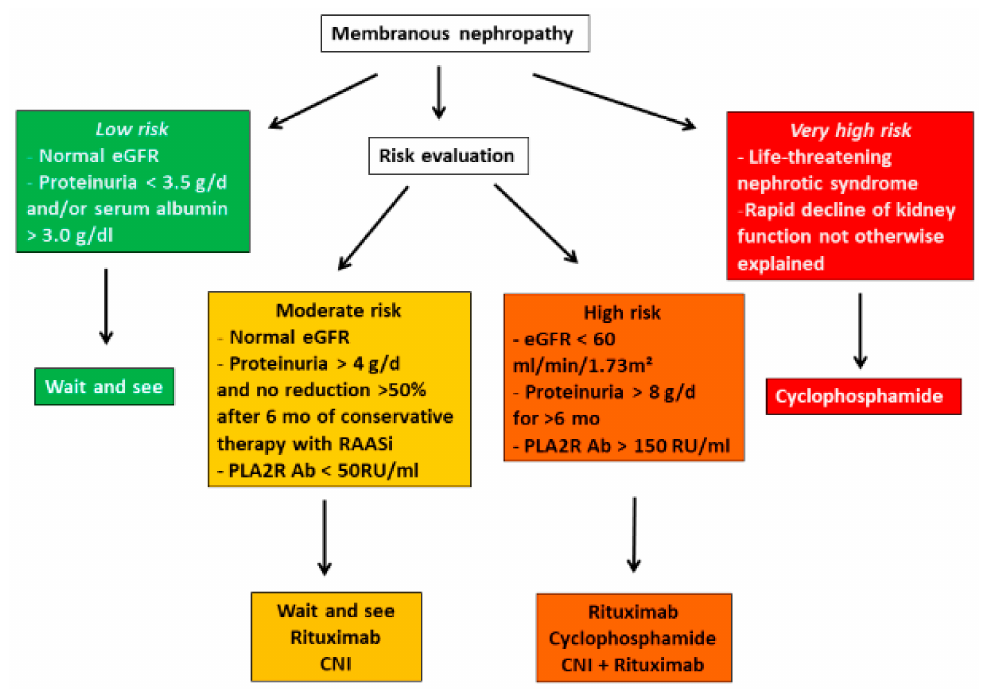
Figure 1. Risk-based treatment of membranous nephropathy (adapted from Clinical Practice Guide- lines for the management of glomerulonephritis